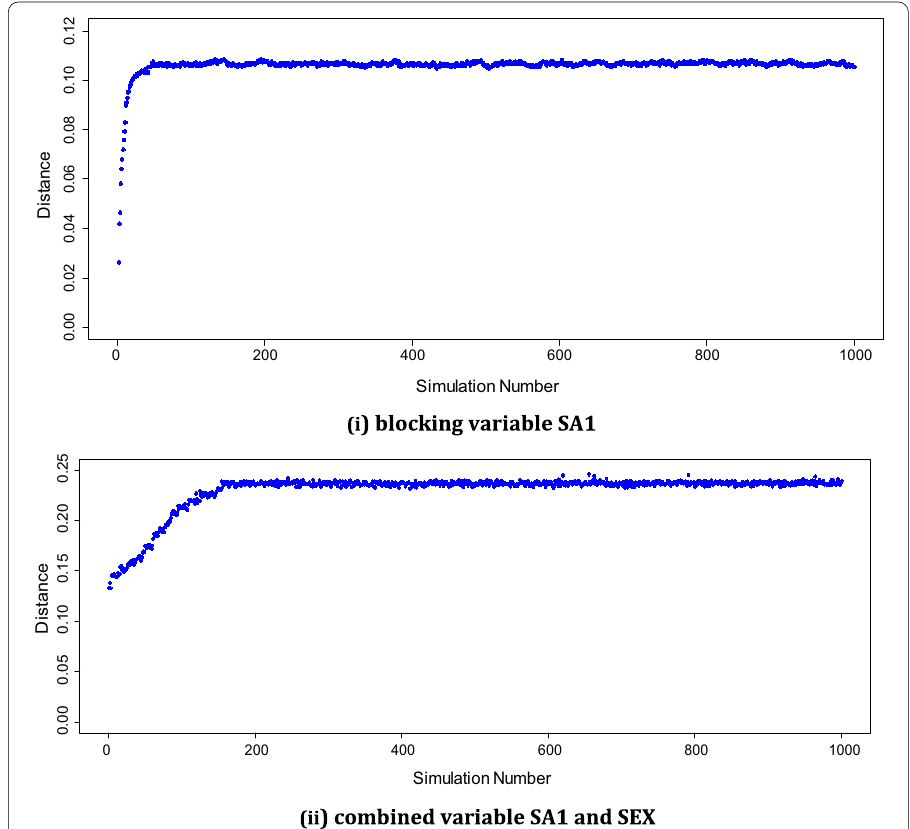
Fig. 3 Distance of A ∗ entries from the initial agreement matrix for blocking variable (i) SA1 and (ii) Combined SA1 and SEX